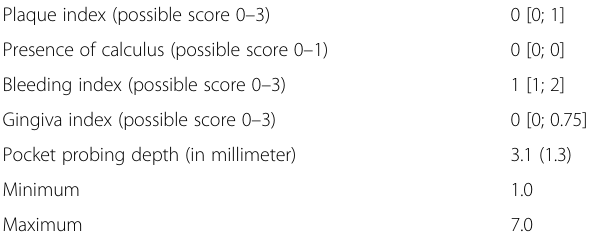
Table 3 Median (IQR) of plaque index, bleeding index, presence of calculus, gingiva index, and mean (sd) of pocket probing depth at time of follow-up evaluation